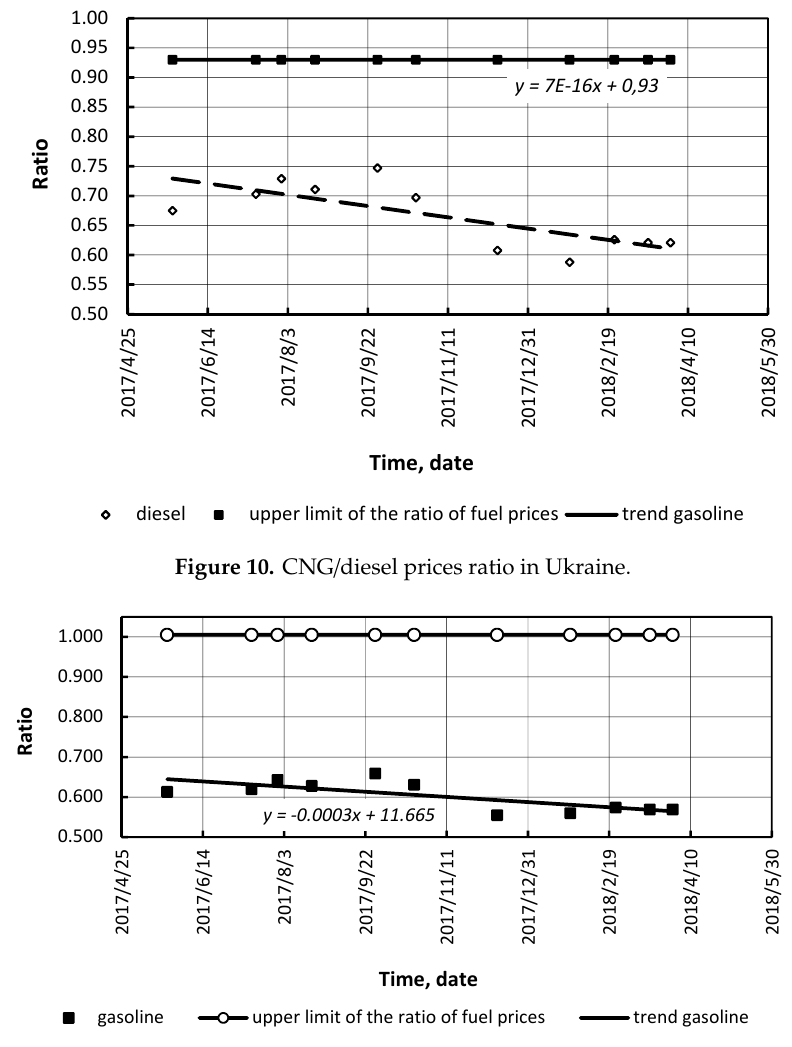
Figure 11. CNG/gasoline prices ratio in Ukraine.